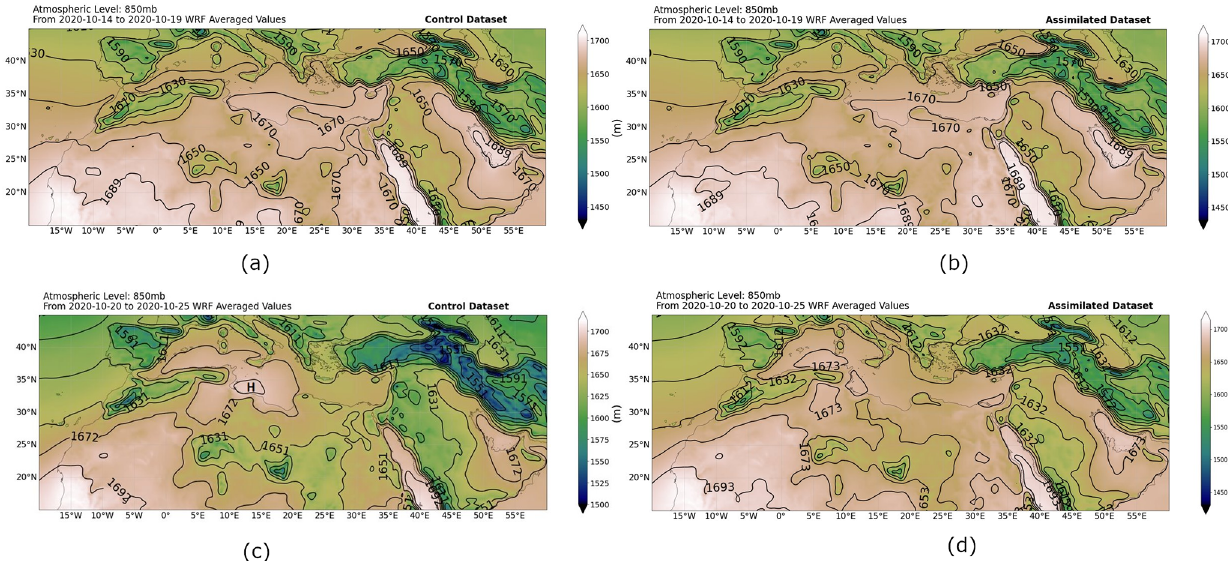
Figure 3. Pressure gradient of model runs for 14–25 October 2020. Representation of the averaged geopotential height for 14–19 October in the control run (a) and assimilated run (b) and for 20–25 October in the control run (c) and assimilated run (d) for the atmospheric layer at 850mbar.